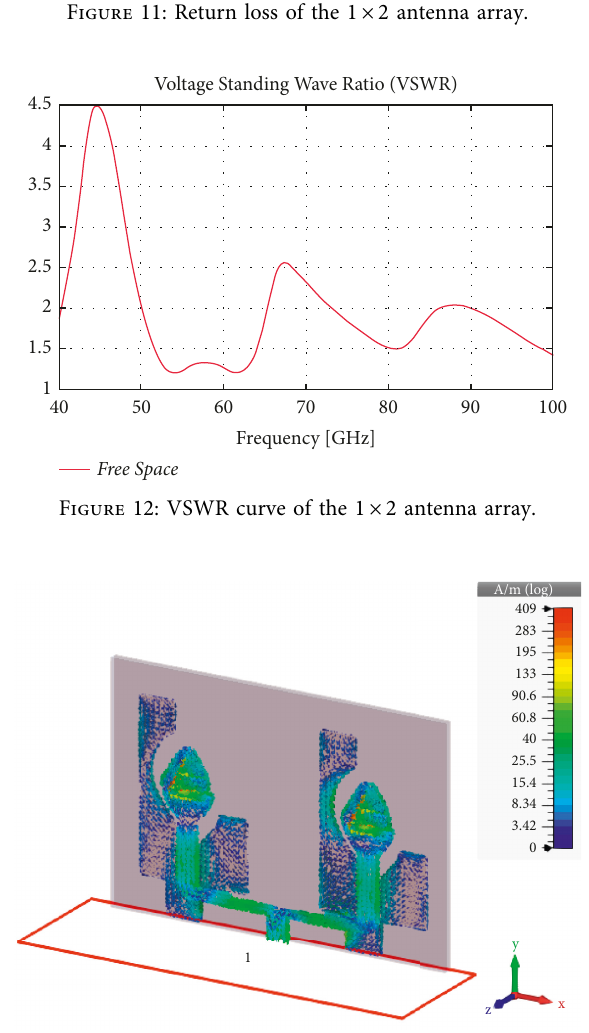
Figure 13: Surface current at 60GHz of the 1 × 2 array.